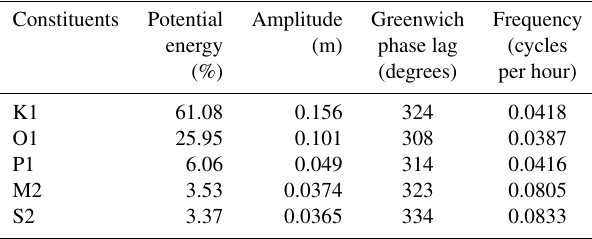
Table 1. Principal tidal constituents for Fremantle tide record from 1970 to